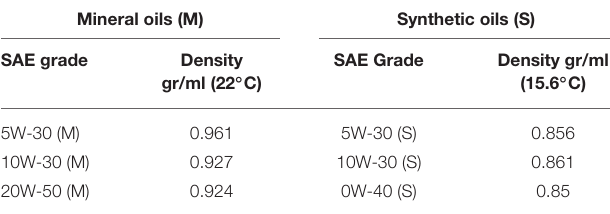
TABLE 1 | Properties of commercial engine oils utilized in this study. Mineral oils